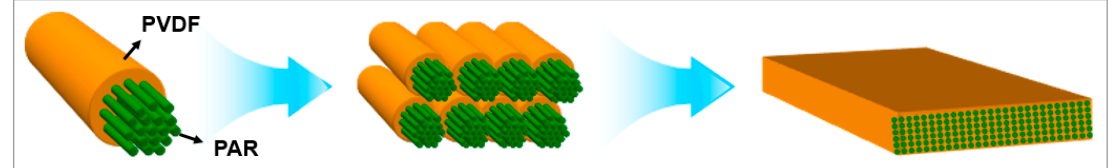
Figure 2. Schematics of the molding process of the PVDF/PAR island-in-a-sea fiber composite.